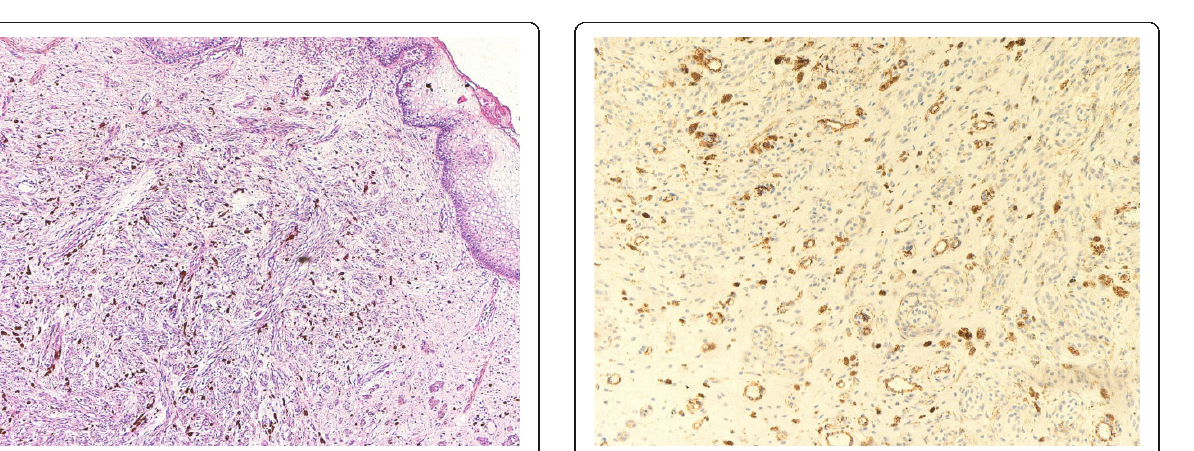
Figure 5 CD31 immunohistochemical stain . There are numerous small-sized vessels within the stroma of the cellular blue